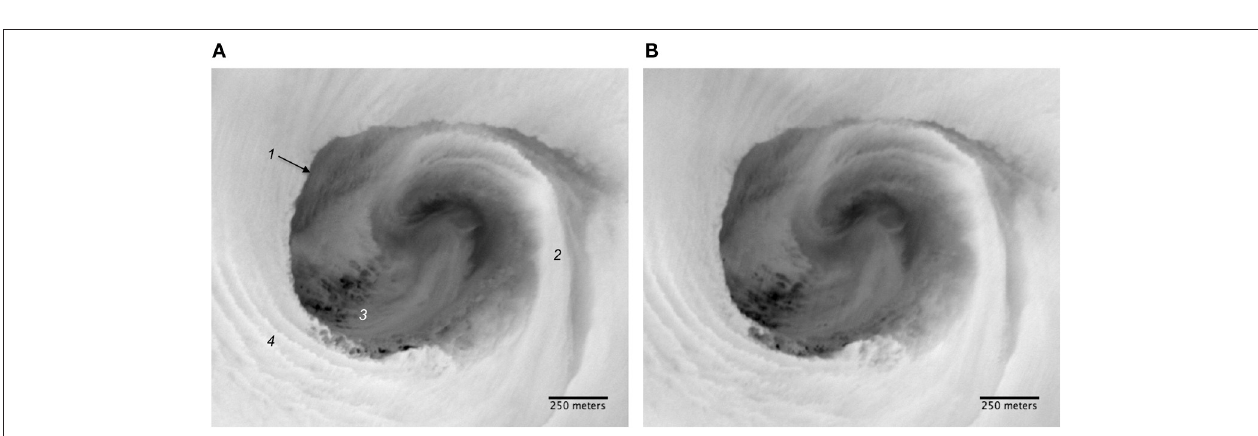
FIGURE 2 | Infrared imagery from two consecutive overpasses on 1 February: (A) 2057 UTC; (B) 2101 UTC. Each panel shows a 1.75- by 1.5-km area of the ocean surface. Annotation in (A) indicates: (1) eddy perimeter; (2) warm inflow; (3) area of small-scale cold patches; (4) persistent azimuthal